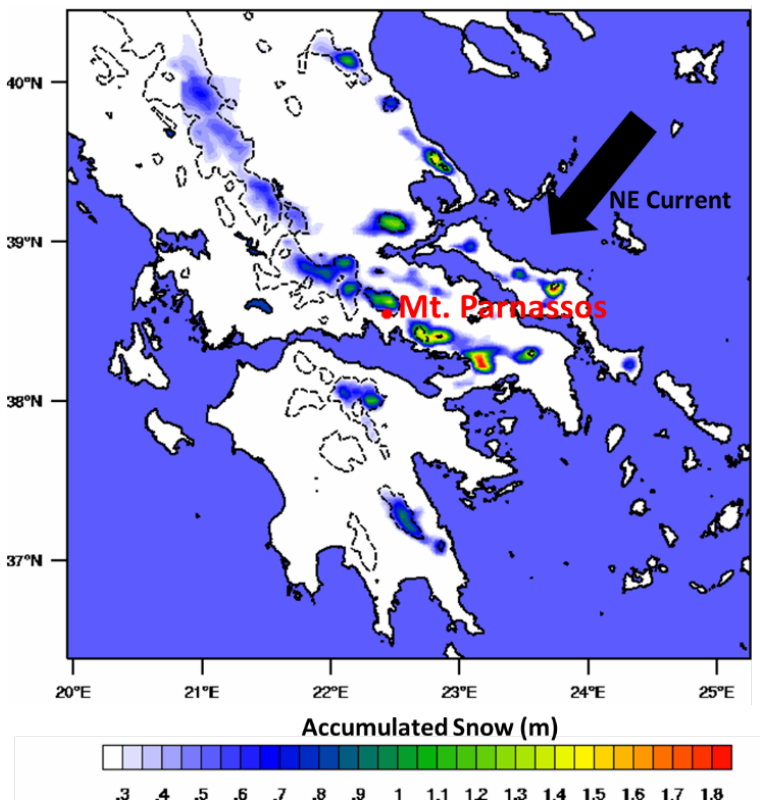
Figure 3. Total accumulated snow (m) at the 2nd model grid, from all three simulations. The dashed contour is the 1000 m topographic elevation.